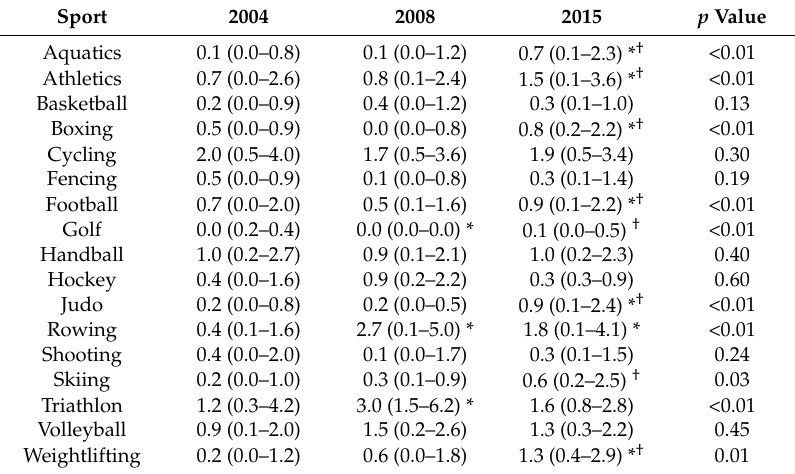
Figure 4. Box-and-whisker plot for caffeine concentrations in the urine samples of Olympic sports collected in 2015. The cross depicts the mean value while the lower, middle, and upper lines of the box represent the 25%, 50%, and 75% percentile. Whiskers represent 1.5 × interquartile range. Outlier data have been removed to facilitate the comprehension of the figure. CYC = Cycling; ROW = Rowing; TRI = Triathlon; ATH = Athletics; WEI = Weightlifting; VOL = Volleyball; HAN = Handball; FOO = Football; JUD = Judo; BOX = Boxing; AQUA = Aquatics; SKI = Skiing; SHO = Shooting; FEN = Fencing; HOC = Hockey; BAS = Basketball; GOL = Golf. (*) Different from GOL at p < 0.05. Table 1. Urine caffeine concentrations ( µ g/mL) in Olympic sports in 2004, 2008, and 2015. Data are medians (25% and 75% percentile) for each